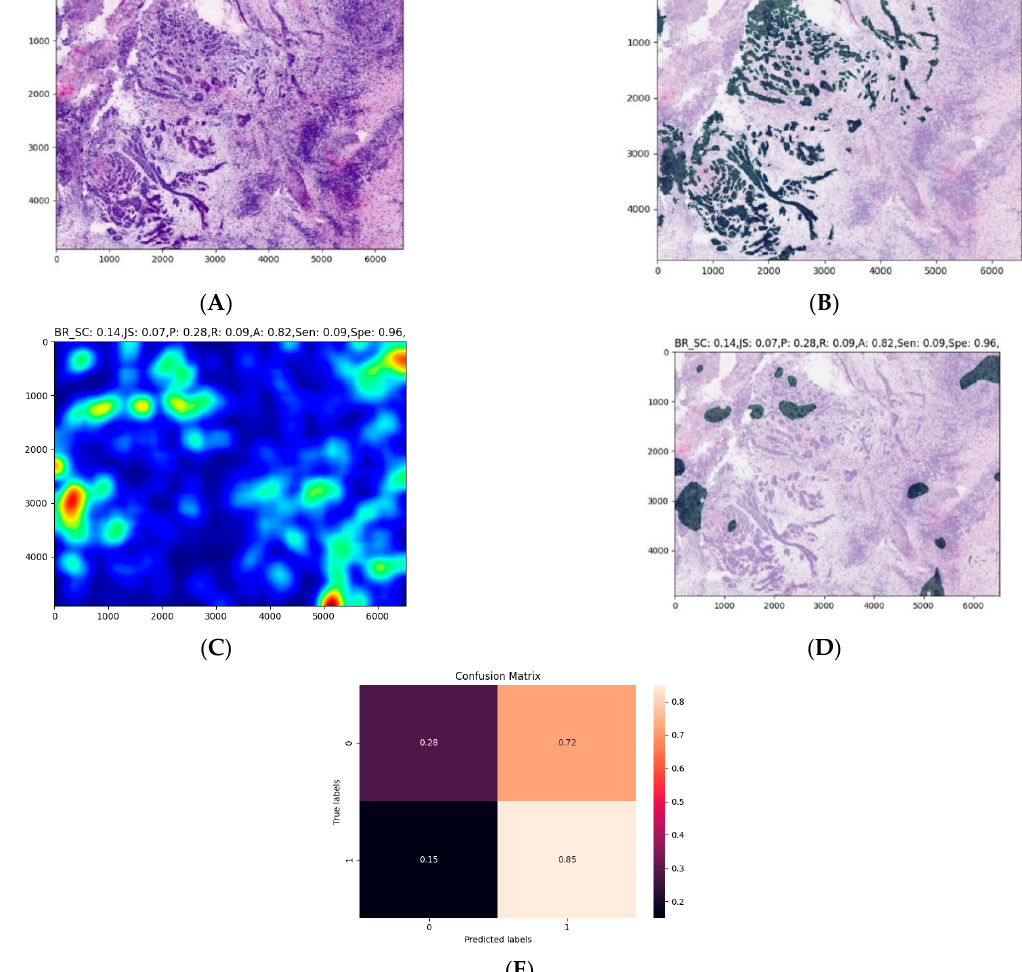
Figure 6. An example of an OSCC ex vivo FCM image with manually annotated cancerous regions and automated prediction. The interpretation of images ( A – E ) is the same as in Figure 4. An entire heatmap and segmentation mask was compared with the experts’ annotations. We can observe poor recognition of fragmented